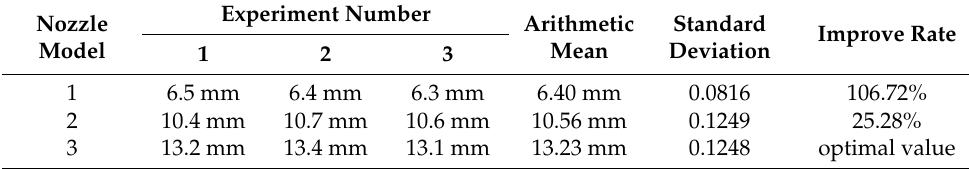
Table 13. Diameter of